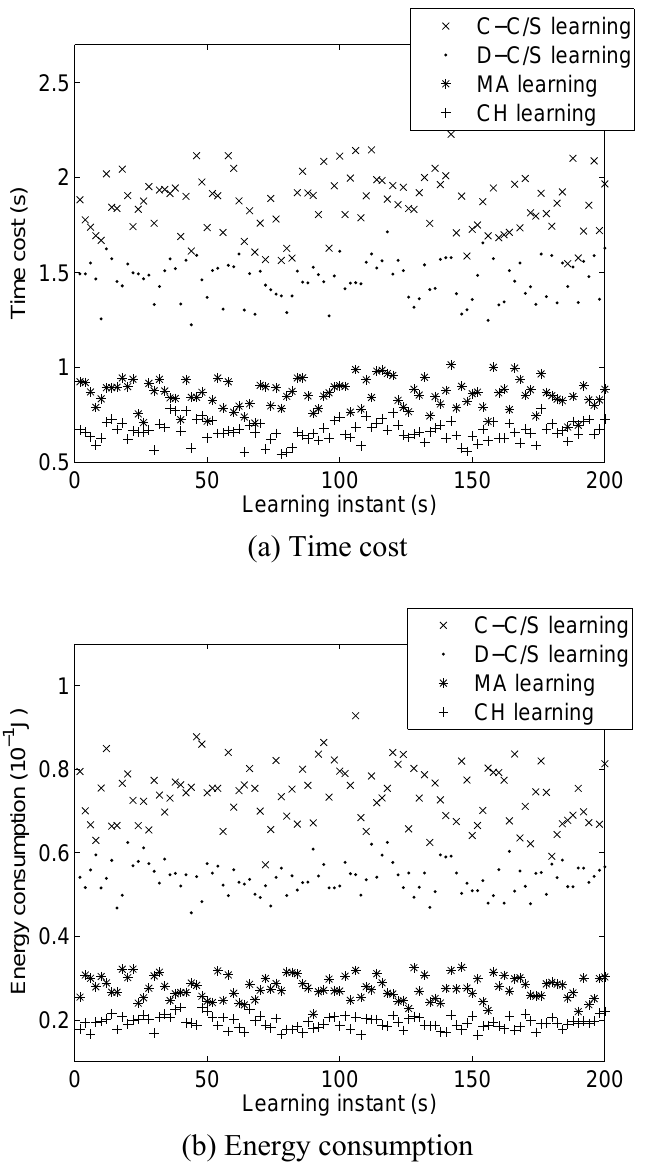
Figure 15. The (a) time cost and (b) energy consumption in 100 iterations of online classifier learning with four different learning